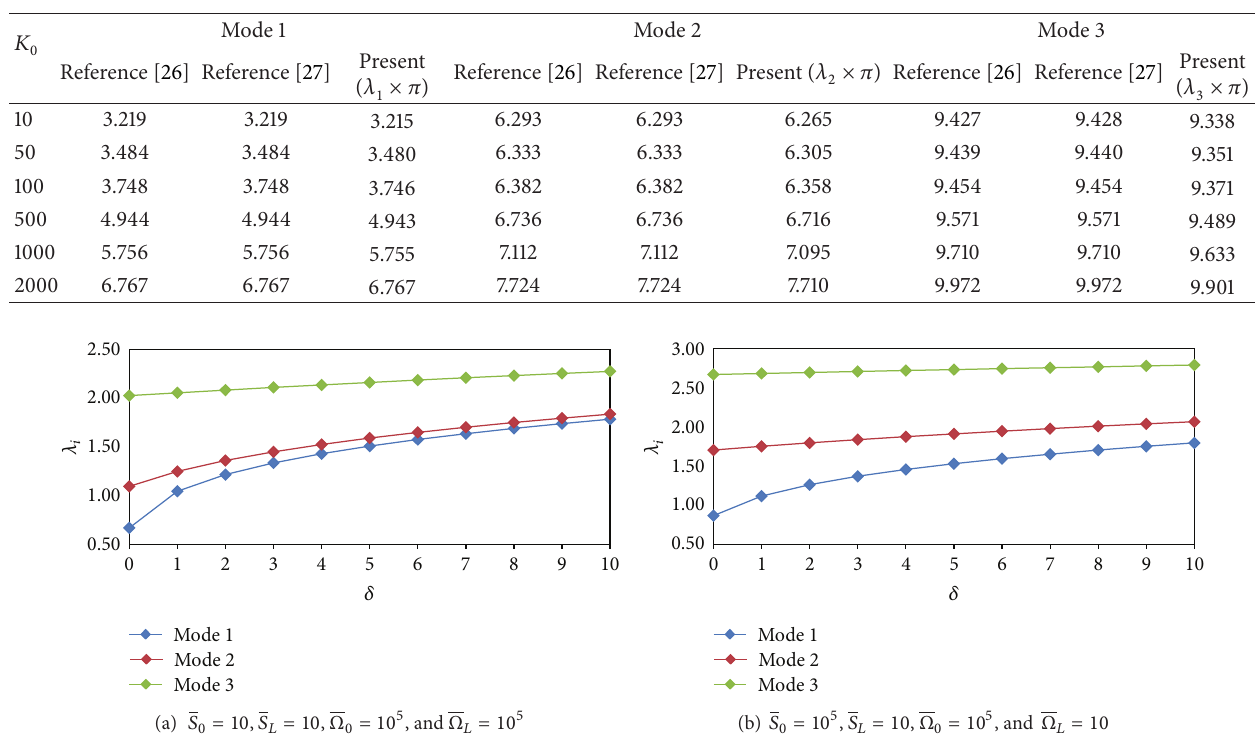
Table 3: Verification of the first three frequency parameters for a simple supported beam.